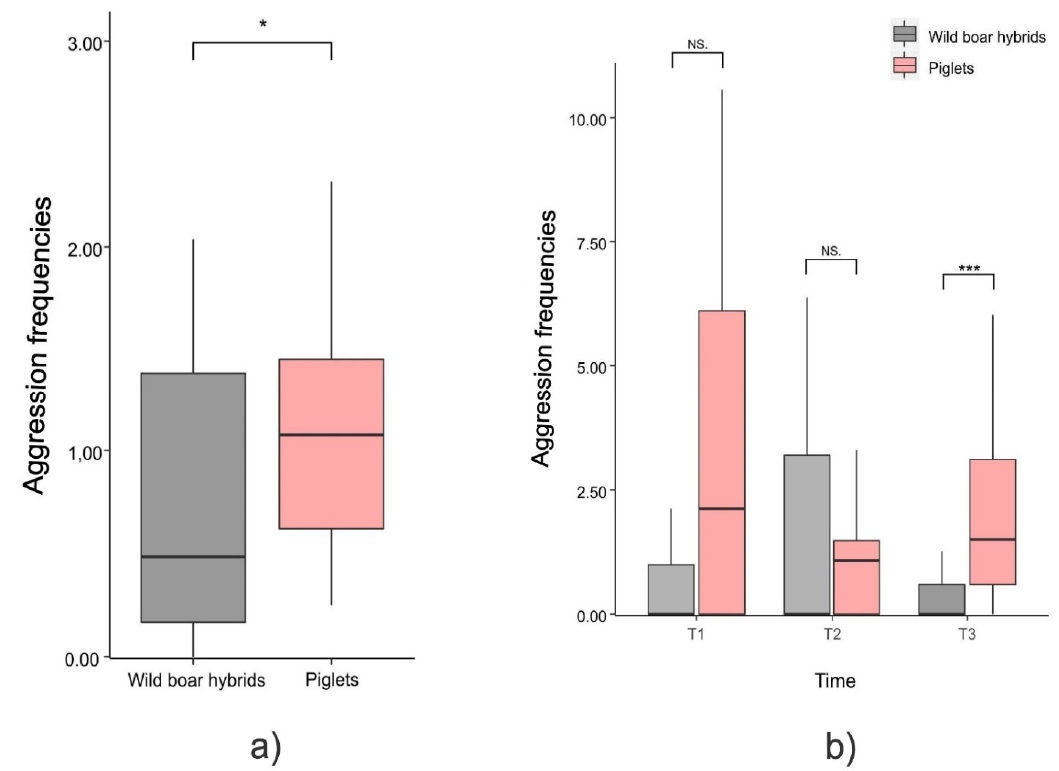
Figure 4. Box plot showing that: ( a ) the overall frequency of aggression are significantly